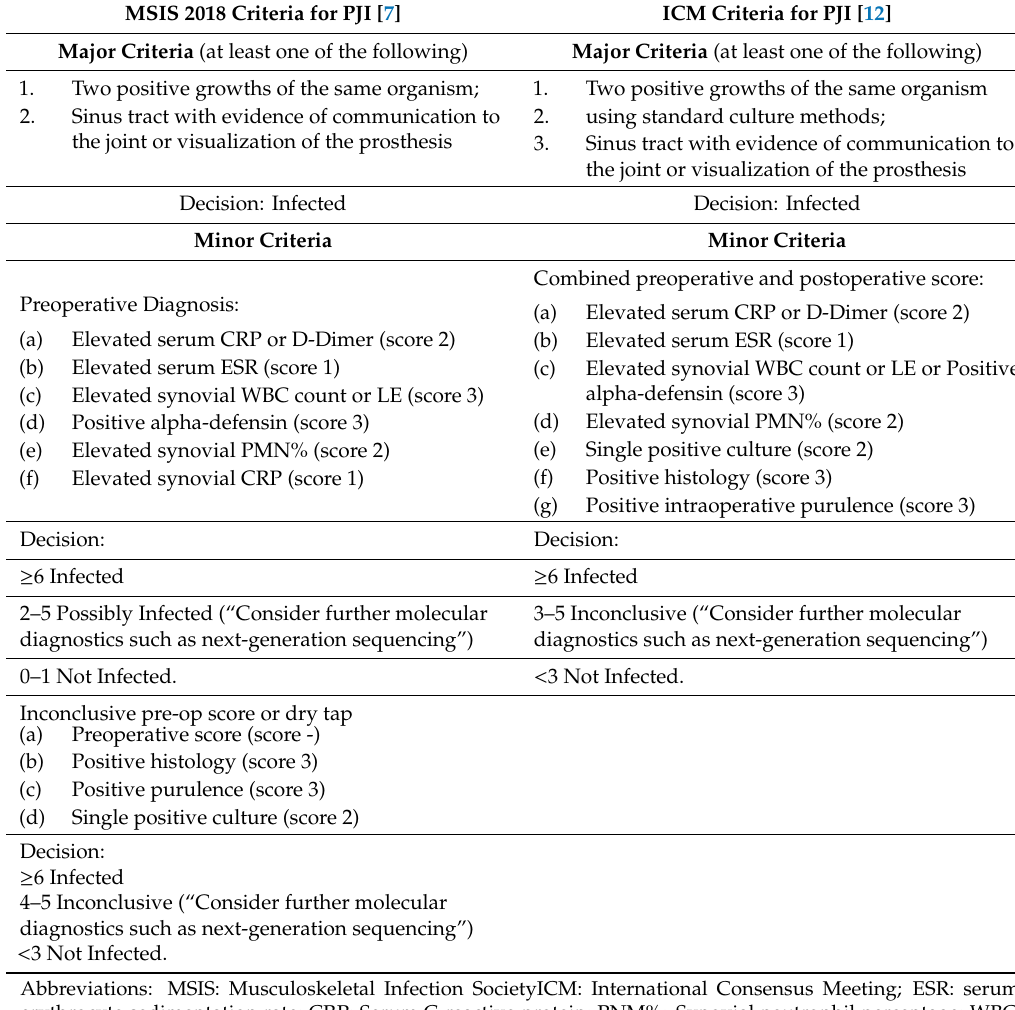
Table 1. Comparison of the “Musculoskeletal Infection Society (MSIS) updated criteria for PJI”, validated in a clinical trial, and the “Proposed 2018 ICM Criteria for PJI” finally voted and released at the International Consensus Meeting (ICM) of Philadelphia in 2018.